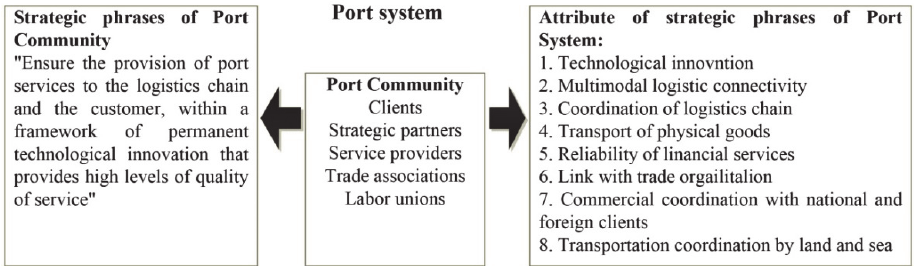
Fig. 2. Phrases and strategic attributes of port system, in the technological and risk